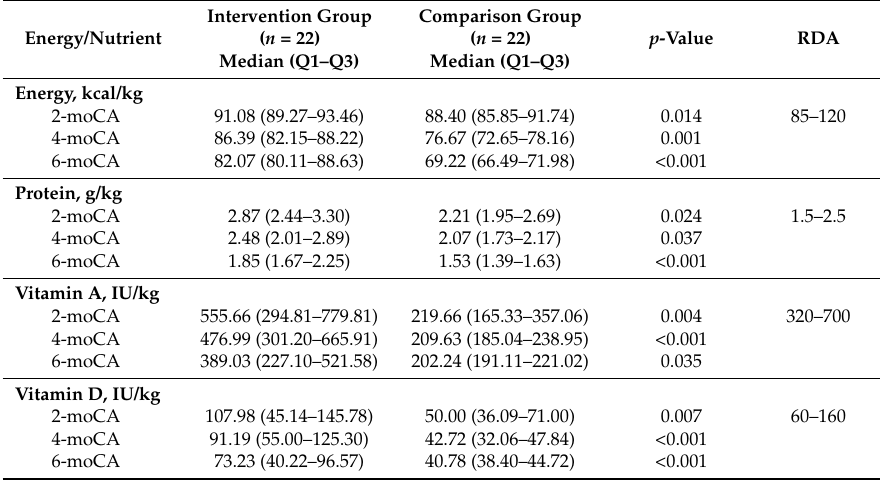
Table 6. Comparisons of daily energy and nutrient intakes of preterm infants between the